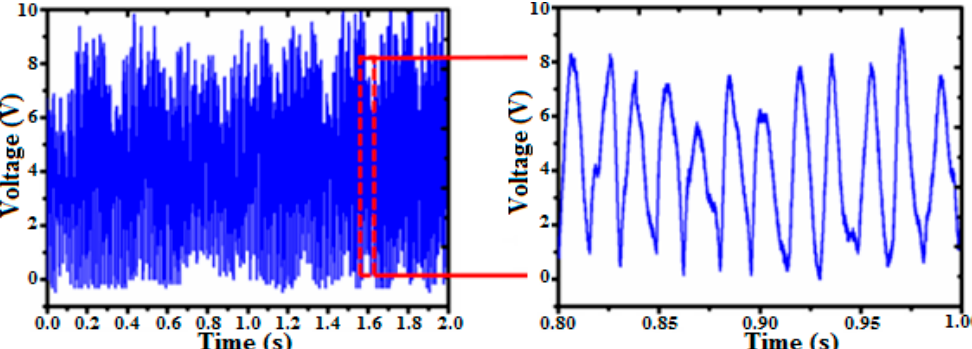
Figure 8. Open circuit voltage analysis of the TENG at a speed of 251 rpm and a temperature difference of 45 °C.